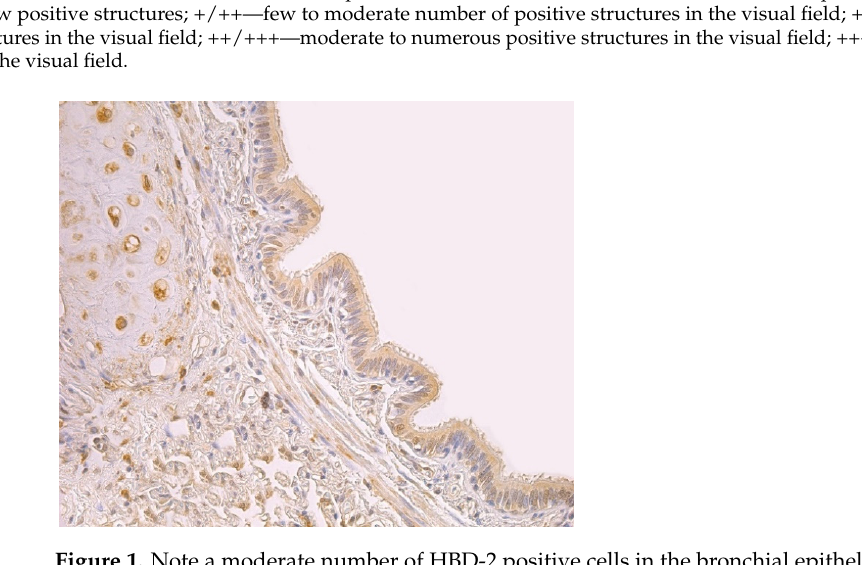
Figure 2. Note a few HBD-3 positive cells in the bronchial and alveolar epithelium, and in connec- tive tissue of 59-year-old female bronchial wall. HBD-3 IMH, ×200. The highest expression of HBD-4 was observed in cartilage of bronchial wall (mod- erate) (Table 2, Figure 3). A few to moderate HBD-4 expression was detected in alveolar epithelium and alveolar macrophages (Table 2, Figure 3). Occasional expression of HBD- 4 was detected in connective tissue, glands and bronchial epithelium (Table 2, Figure 3). Table 2. Relative number of HBD-4-positive structures in the healthy lung structures: cartilage, connective tissue, glands, bronchial epithelium, alveolar macrophages and alveolar epithelium. Nr